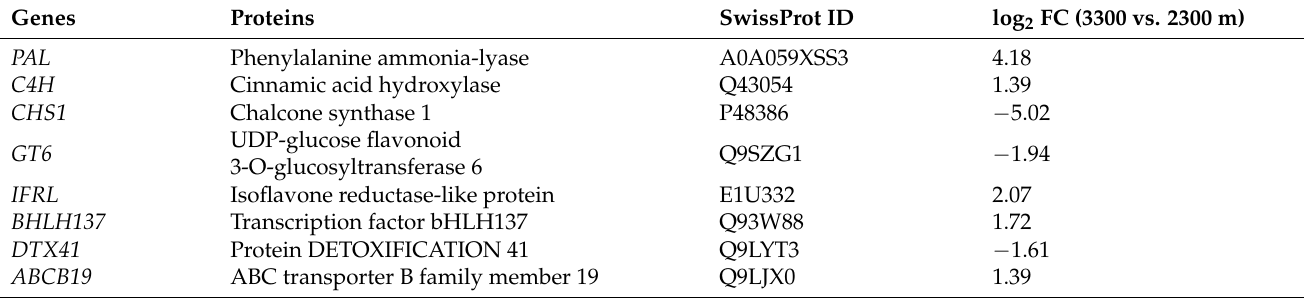
Table 2. Twenty-two DEGs involved in flavonoid biosynthesis at 3300 vs. 2300